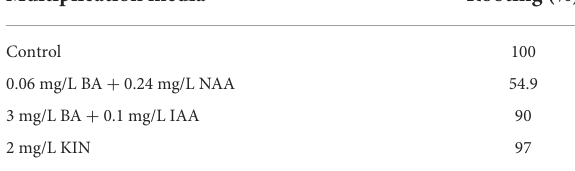
TABLE 3 Percentage of rooting of sea knotgrass shoots cultivated in MS medium, obtained from different multiplication media, after 60